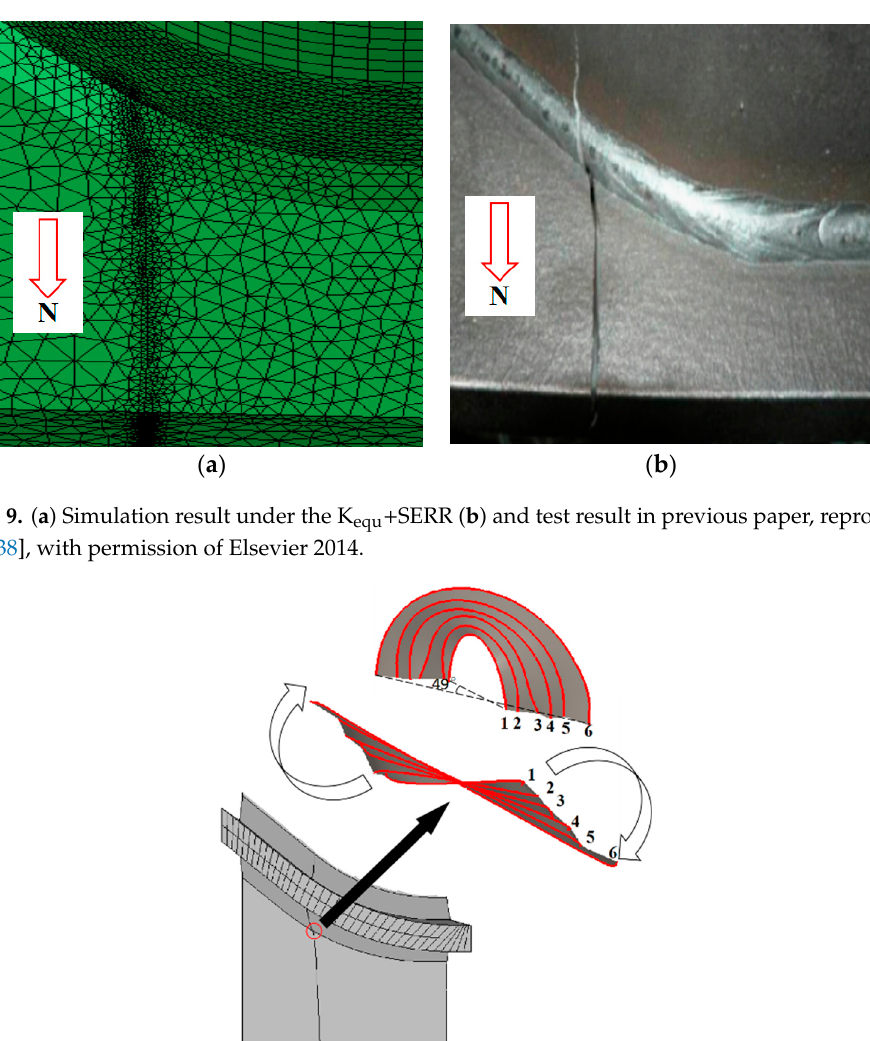
Figure 11. Schematic diagram of crack propagation evolution. Table 4. Stages of crack propagation. Number of stages